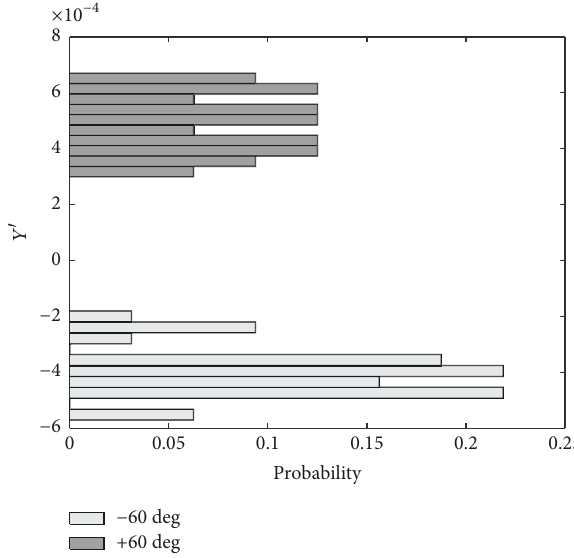
Figure 13: Histogram of the probability of passage at 𝑌 󸀠 for 𝑋 󸀠 = 1.125 × 10 −3